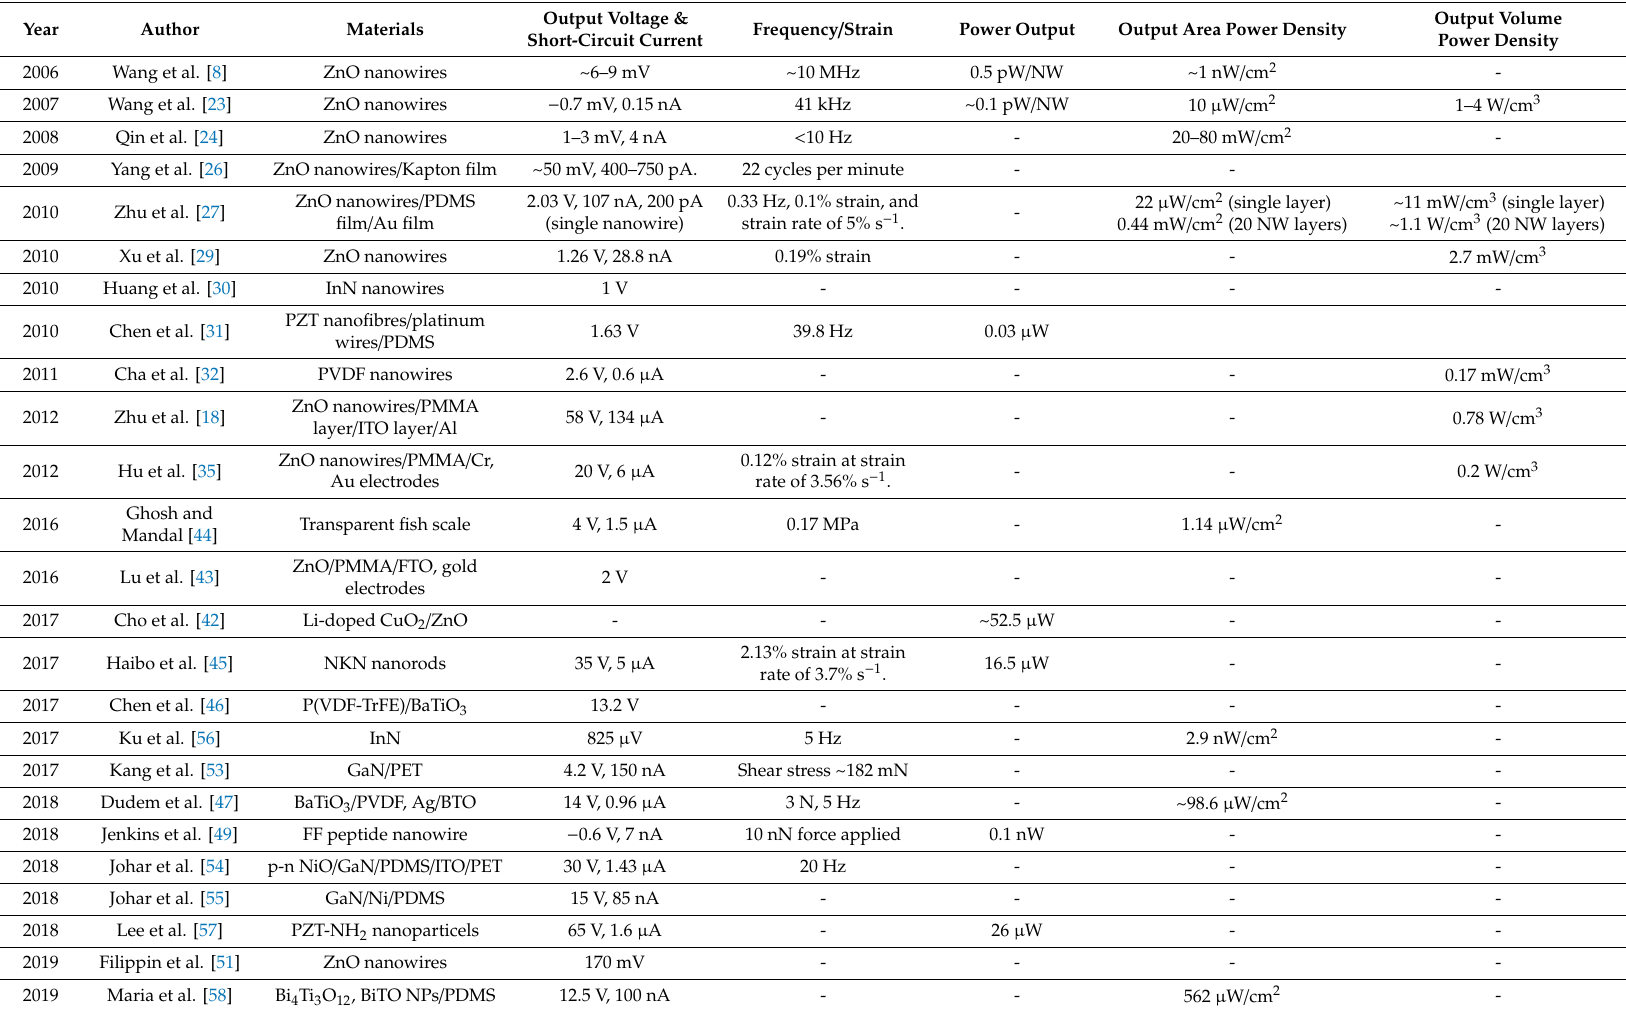
Table 2. Significant improvements in the development of